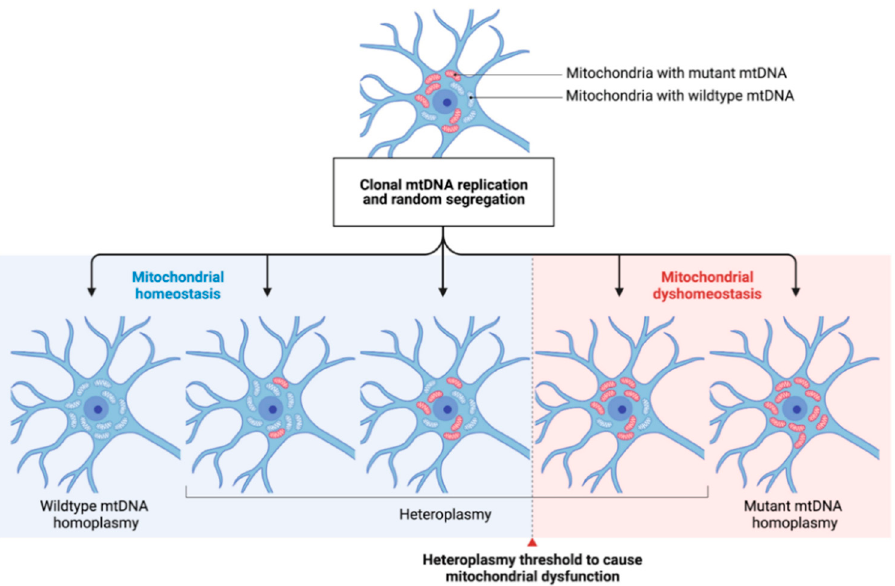
Figure 2. The concept of mtDNA heteroplasmy and its contribution to mitochondrial dysfunction in PD. The arbitrary occurrence of mtDNA mutations (depicted by red-colored mitochondria) and their respective clonal expansion leads to different degrees of heteroplasmy in a given neuronal cell. Cell-specific heteroplasmy thresholds (dashed line) to cause mitochondrial dysfunction are widely unknown. By, e.g., shifting the degree of heteroplasmy towards a higher ratio of wildtype/mutated mtDNA, mitochondrial homeostasis might be restored. mtDNA: mitochondrial DNA.